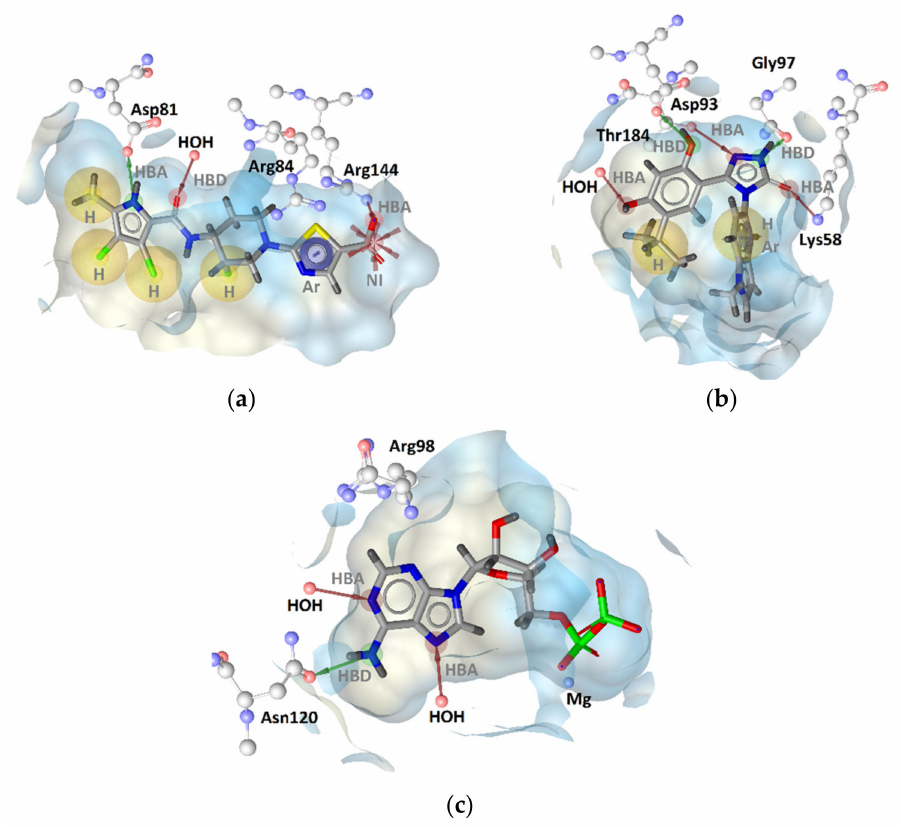
Figure 2. Comparison of crystal structures of ( a ) GyrB (PDB entry: 3TTZ) in complex with pyrrolamide-based inhibitor, ( b ) Hsp90 (PDB entry: 3TUH) in complex with inhibitor ganetespib, and ( c ) TopoII (PDB entry: 4R1F) in complex with ADP. The interaction features were derived using LigandScout 4.4 [29]. Hydrophobic features (H) are shown as yellow spheres, negative ionizable (NI) as a red star, aromatic ring (Ar) as a blue disc, hydrogen-bond donors (HBD) as green arrows, and hydrogen-bond acceptors (HBA) as red